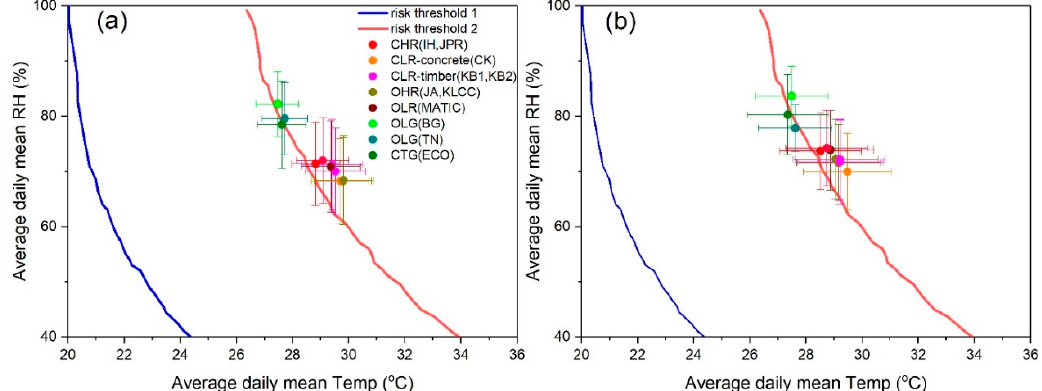
Figure 5. Measured average daily and average daily mean temperature (T) and relative humidity (RH) values in different land-use areas against the risk threshold derived by Mora et al. [45] in wet ( a ) and dry months ( b ).